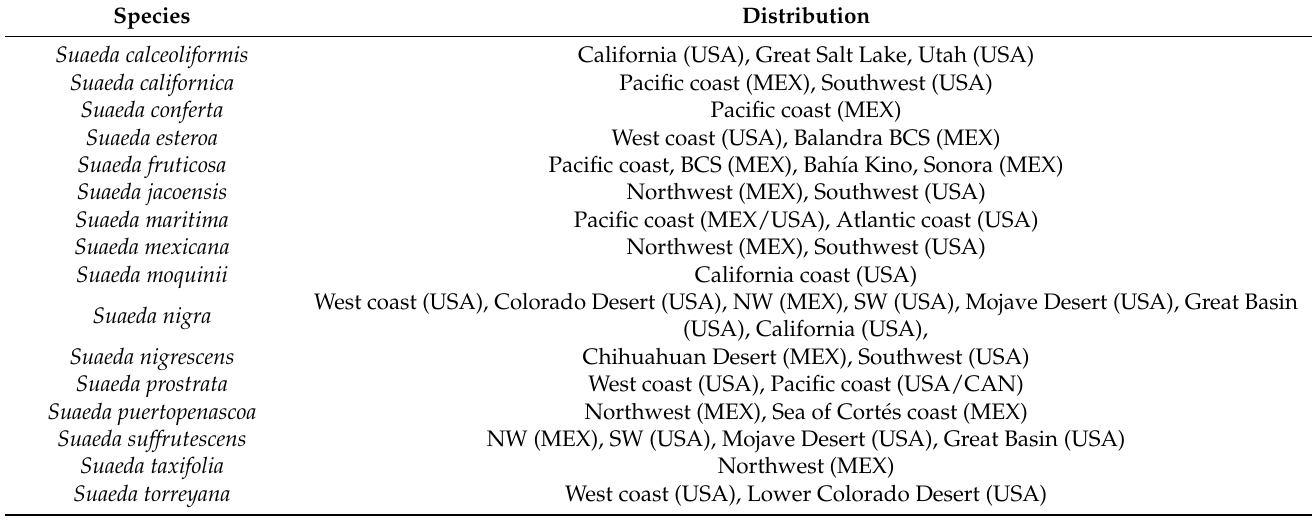
Table 1. Distribution of 16 halophytic species of the genus Suaeda , family Amaranthaceae (species are listed in alphabetical order). Species Distribution Suaeda